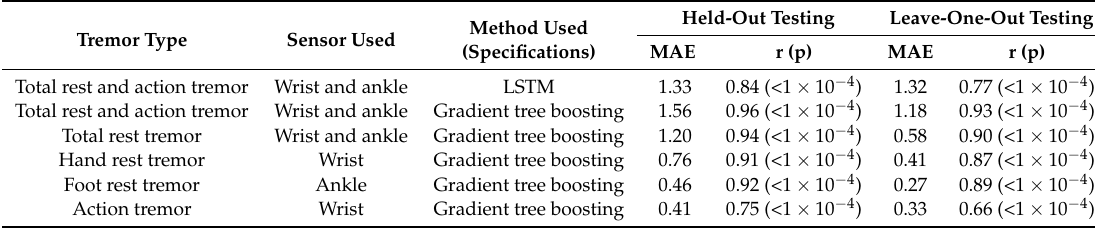
Table 3. Validation and testing results using data from 24 PD